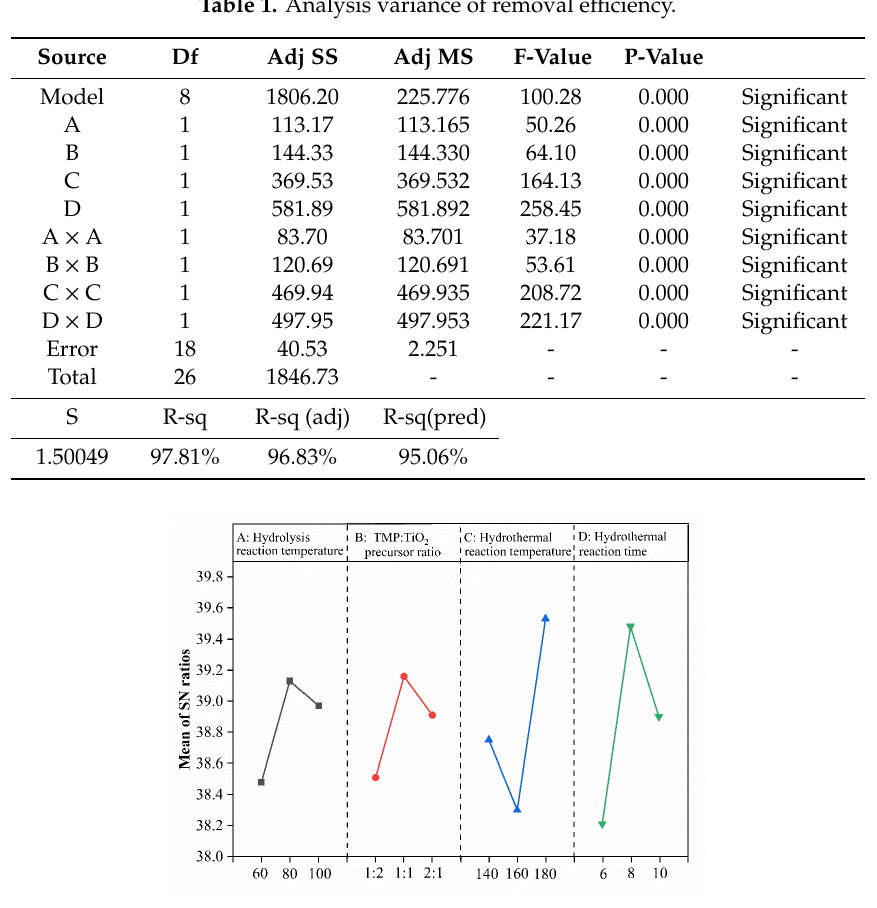
Figure 1. Response graph for S/N ratios.